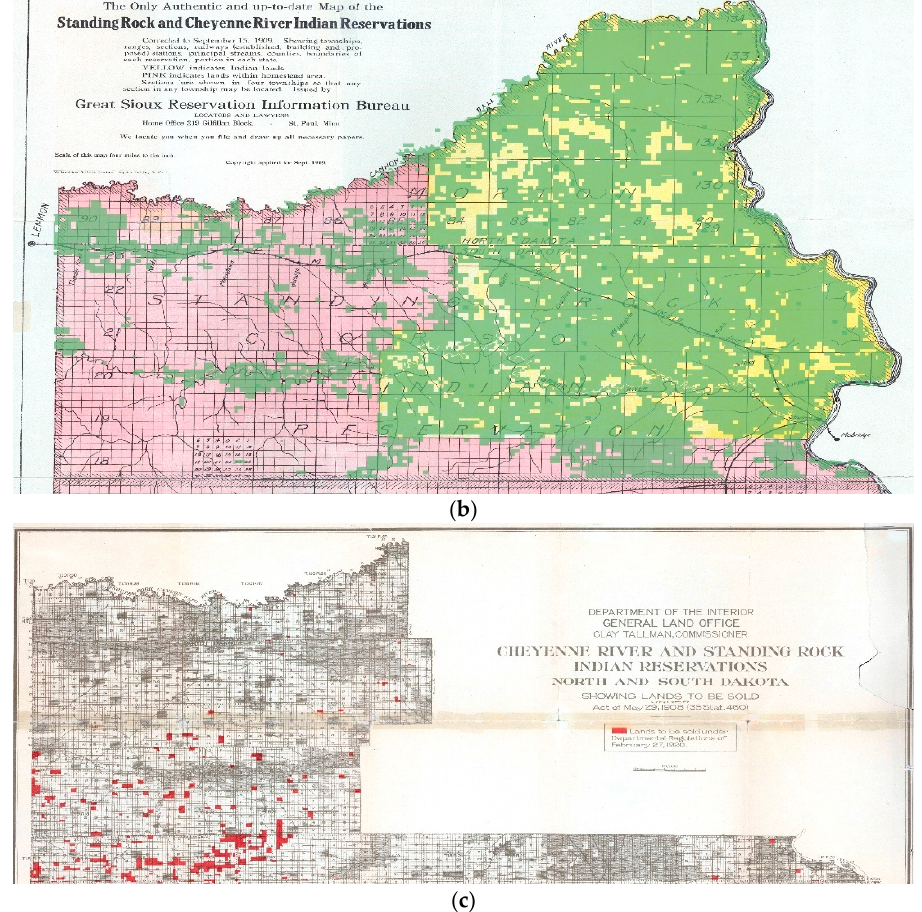
Figure 14. ( a ) 1909 map of surplus reservation lands available for sale to non-tribal members after allotment (pink) versus lands set aside for the tribe (yellow). (South Dakota State Historical Society Digital Archives: 2019-09-25-0004). ( b ) Allotments (green) overlaid on the map, confirming that the majority of land allotted on the reservation lies within the designated yellow area. ( c )1920 map showing remaining surplus lands after allotment. Dark grey areas are allotments outside of the previously designated areas to the east. These areas match green areas in Figure 14b. (South Dakota State Historical Society Digital Archives: 2019-09-25-0006).